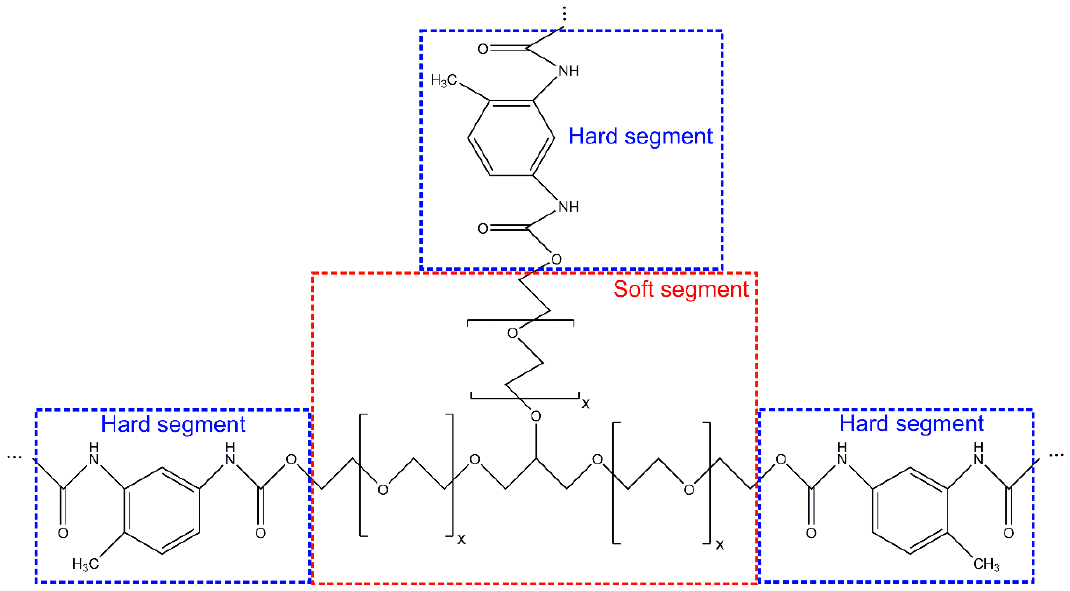
Figure 1. Chemical structure of flexible polyurethane foams.